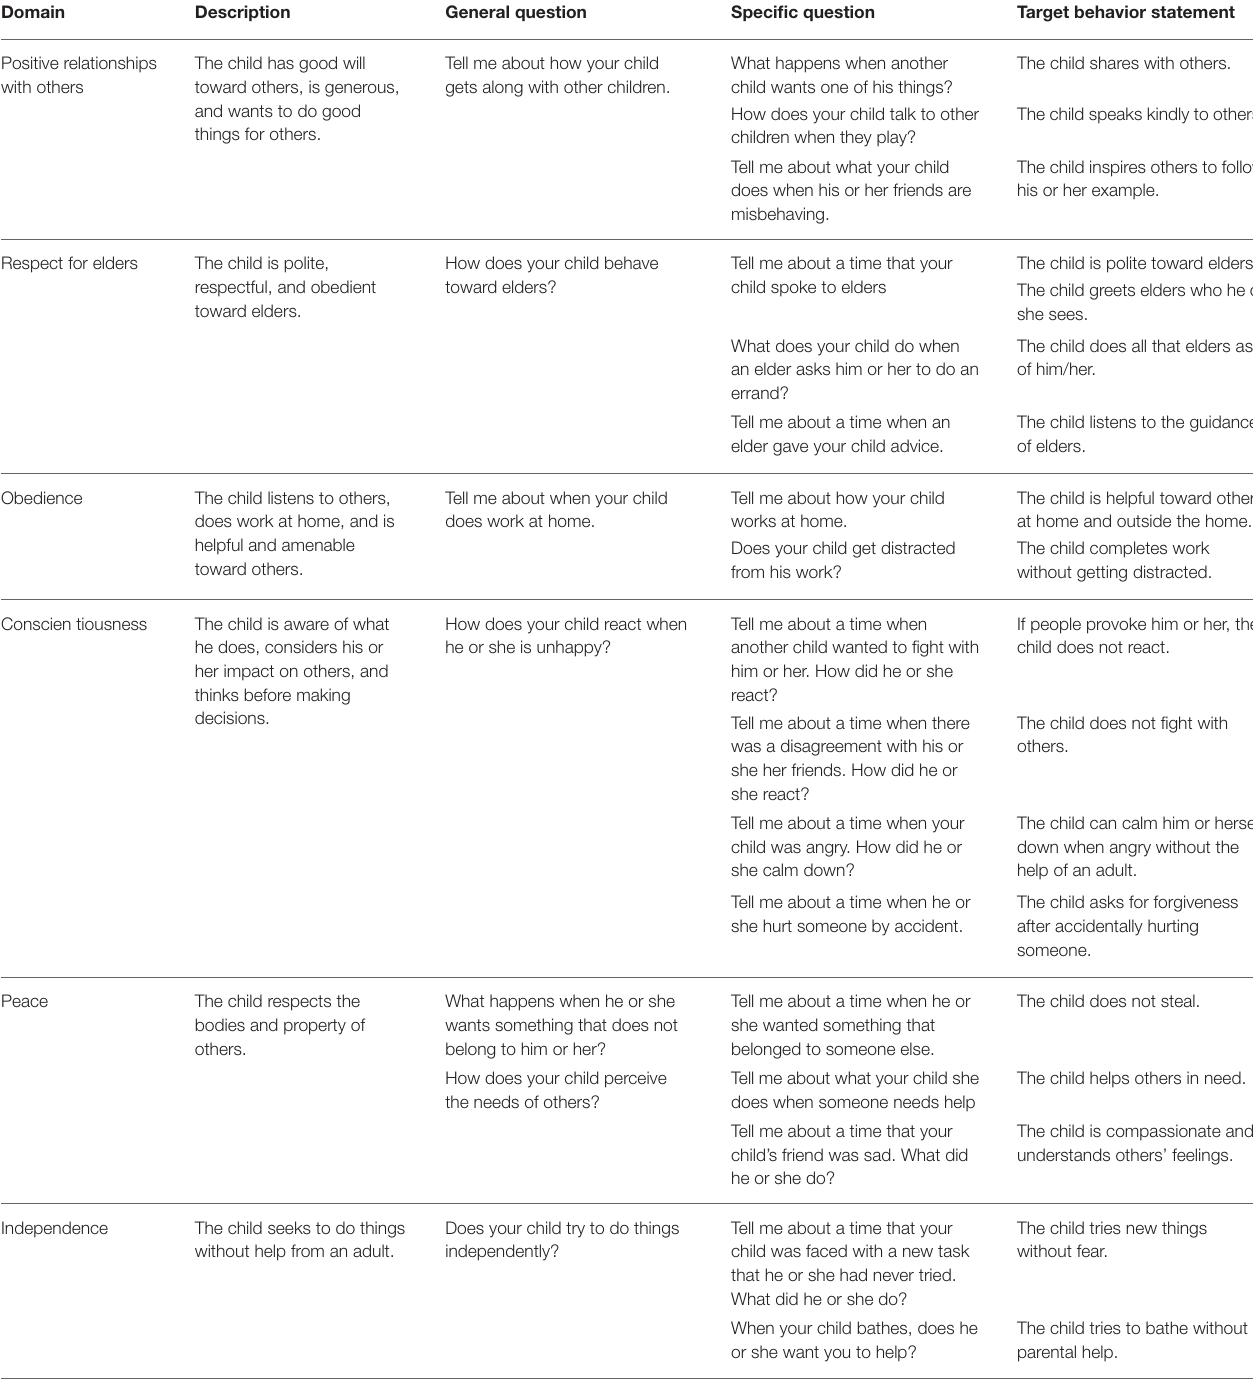
TABLE 11 | Revised questions and target behavior statements after initial piloting.